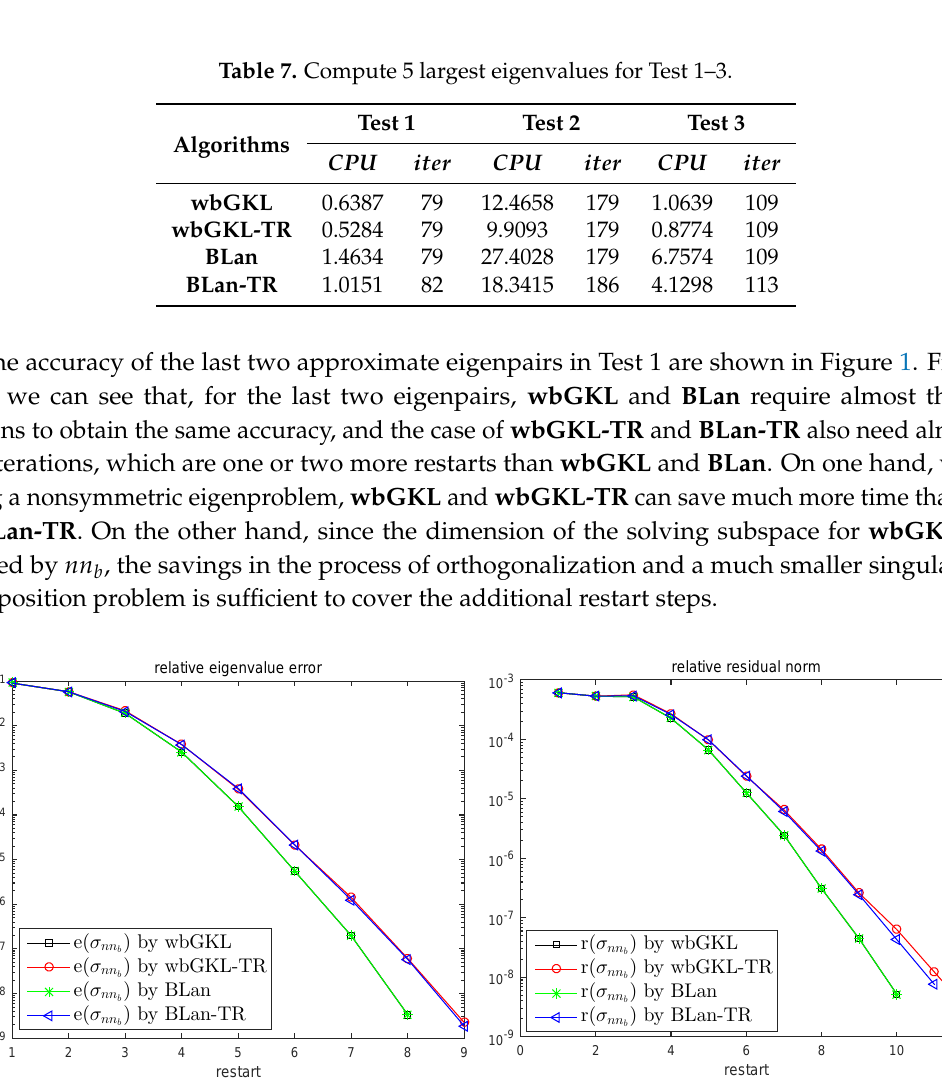
Figure 1. Errors and residuals of the 2 smallest positive eigenvalues for Test 1 in Example